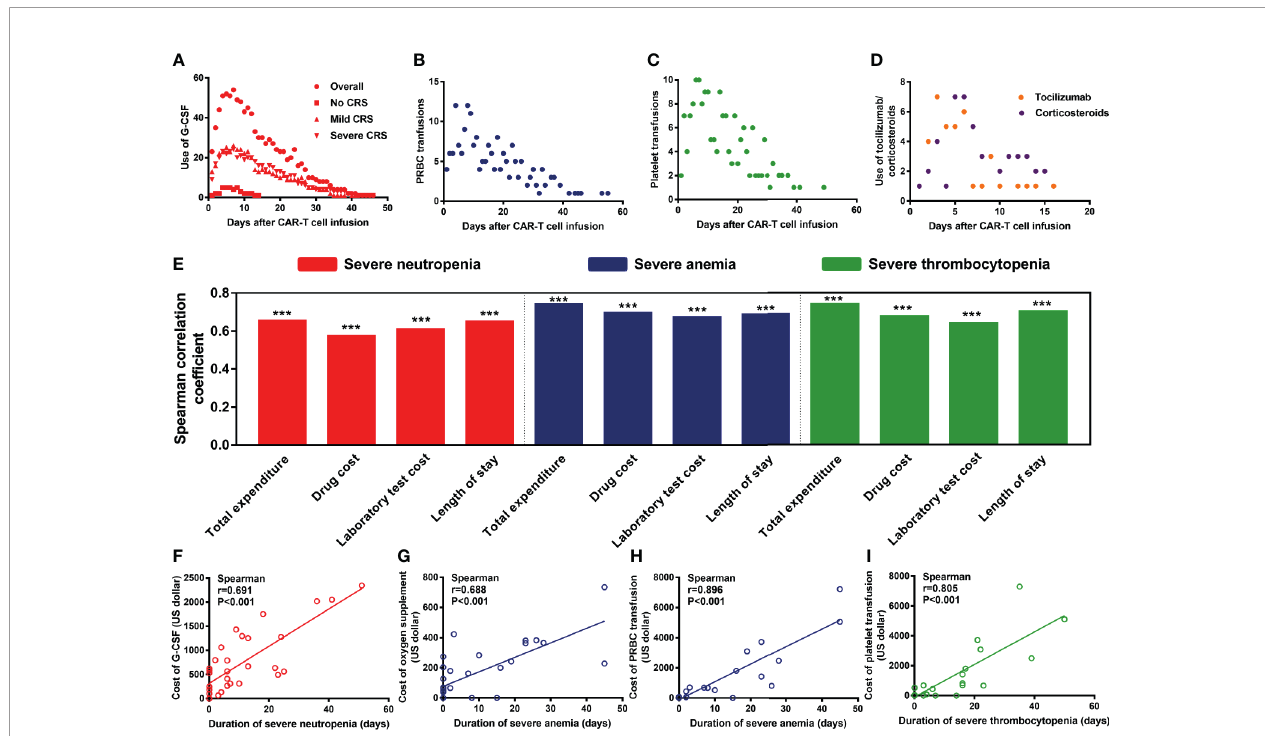
FIGURE 6 | Management of severe cytopenia and the correlation between severe cytopenia and hospitalization expenses/length of stay. P values and r values were determined by Spearman correlation analysis. ***P < 0.001. G-CSF, granulocyte colony-stimulating factor; PRBC, packed red blood cells. (A – D) Frequencies of G-CSF administration, PRBC and platelet transfusion, and tocilizumab/ corticosteroid administration after CAR-T cell infusion. (E – I) The duration of severe cytopenia was strongly associated with the length of stay and hospitalization